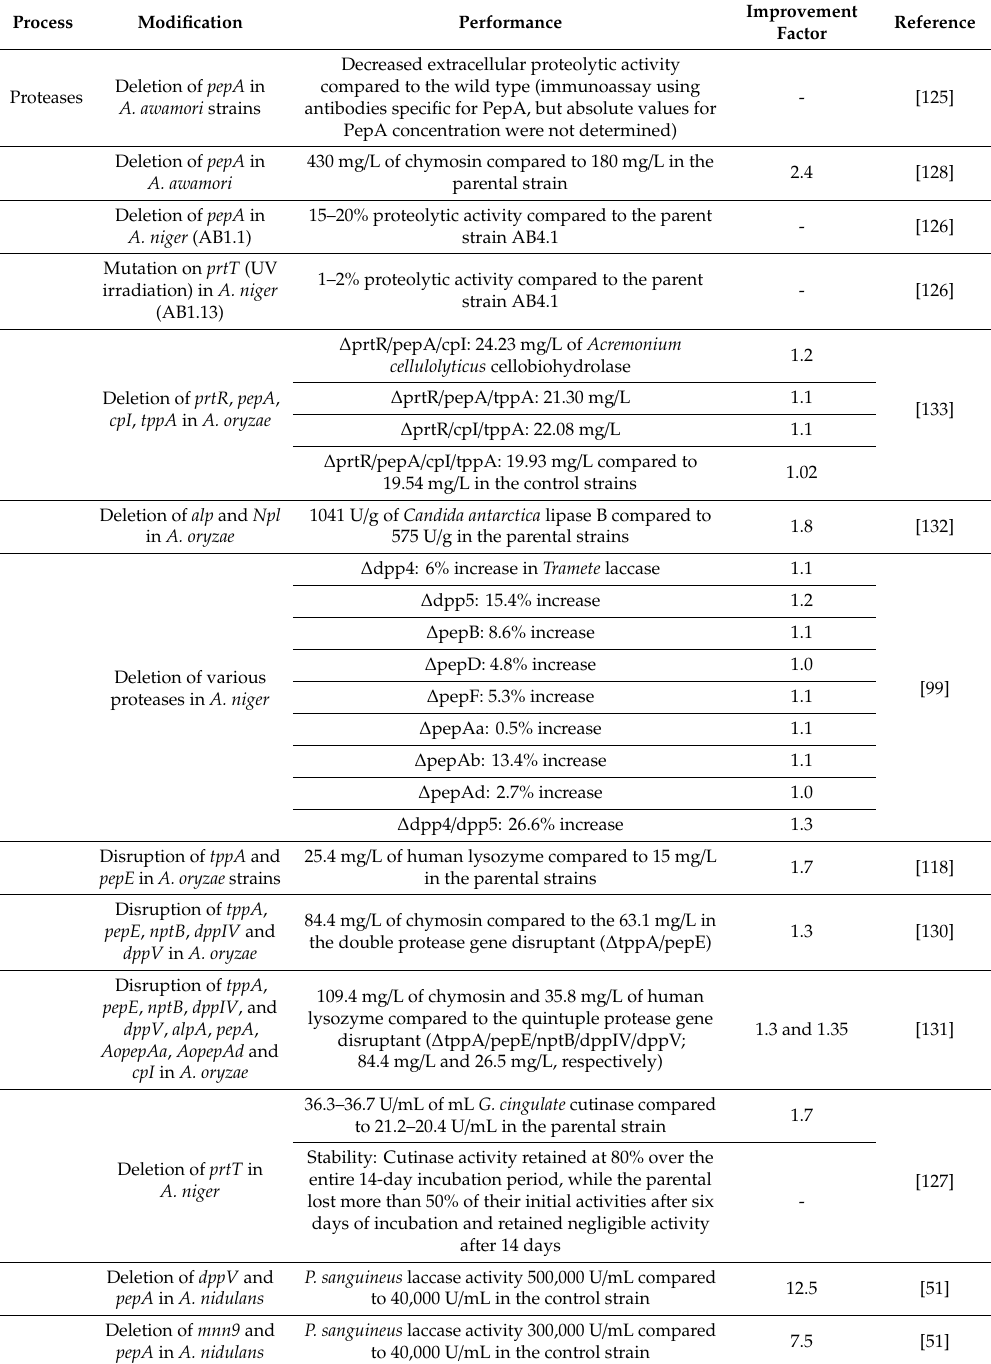
Table 10. Approachesforimprovingrecombinantproteinproductionthroughdisruptionofproteasegenes.